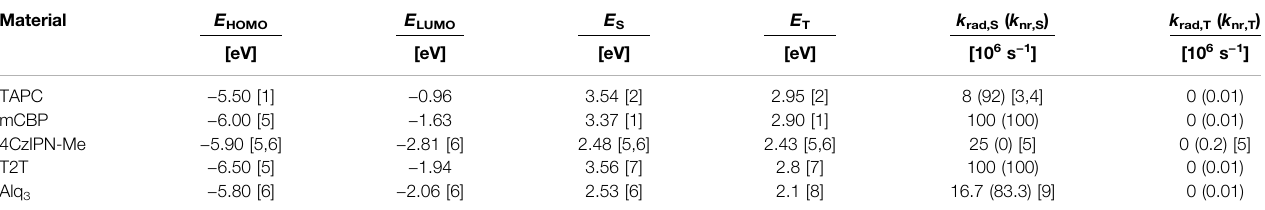
TABLE1| Material-speci fi cparametersusedfortheKMCsimulations. E HOMO and E LUMO aregivenwithrespecttothevacuumlevel.Thesinglet(triplet)energies E S(T) andthe radiative (non-radiative) decay rates k rad ( k nr ) are obtained from the references indicated or are given an assumed value. Values are taken from the following papers: [1] Nakanotani et al. (2014), [2] Jankus et al. (2014), [3] Seino et al. (2014), [4] Hensel and Bässler (1992), [5] Furukawa et al. (2015), [6] Yoshida and Yoshizaki (2015), [7] Chen et al. (2009), [8] Burrows et al. (2003), and [9] Matsumoto et al. (2008).